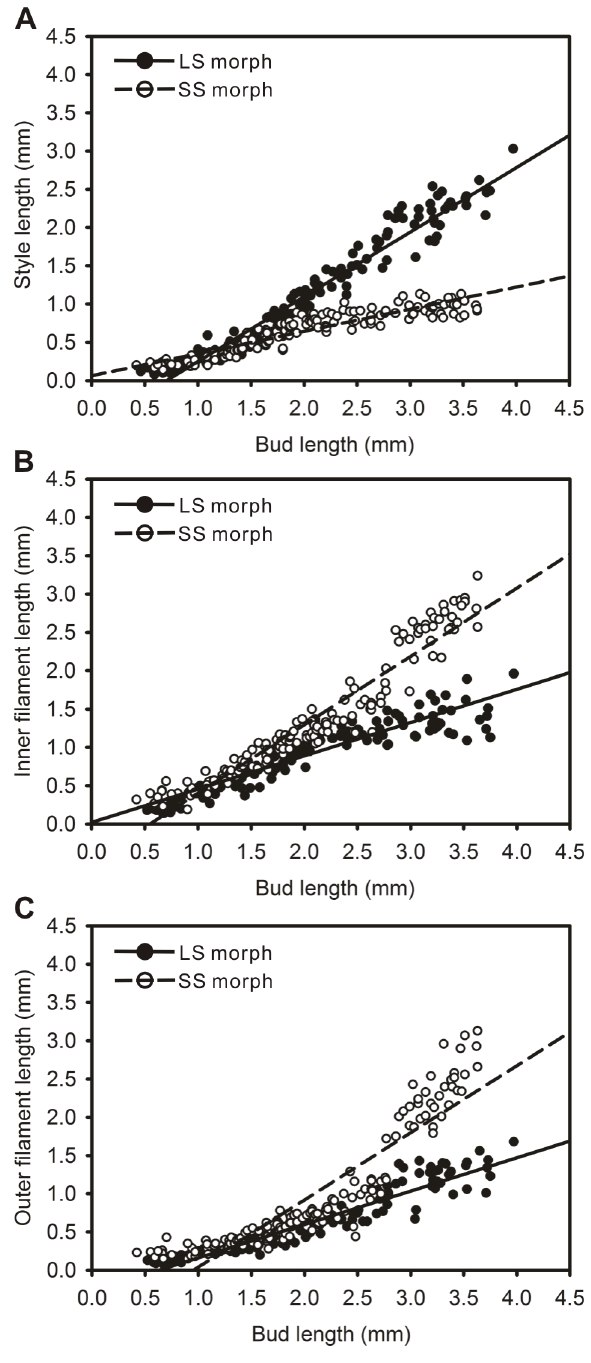
Figure 5. The number of epidermal cells in a single cell column along styles or filaments during the floral development of Polygonumjucundum . A, Style; B, Inner filament; C, Outer filament. Trend lines were plotted separately for the data for each floral morph. Error bars indicate counting errors.